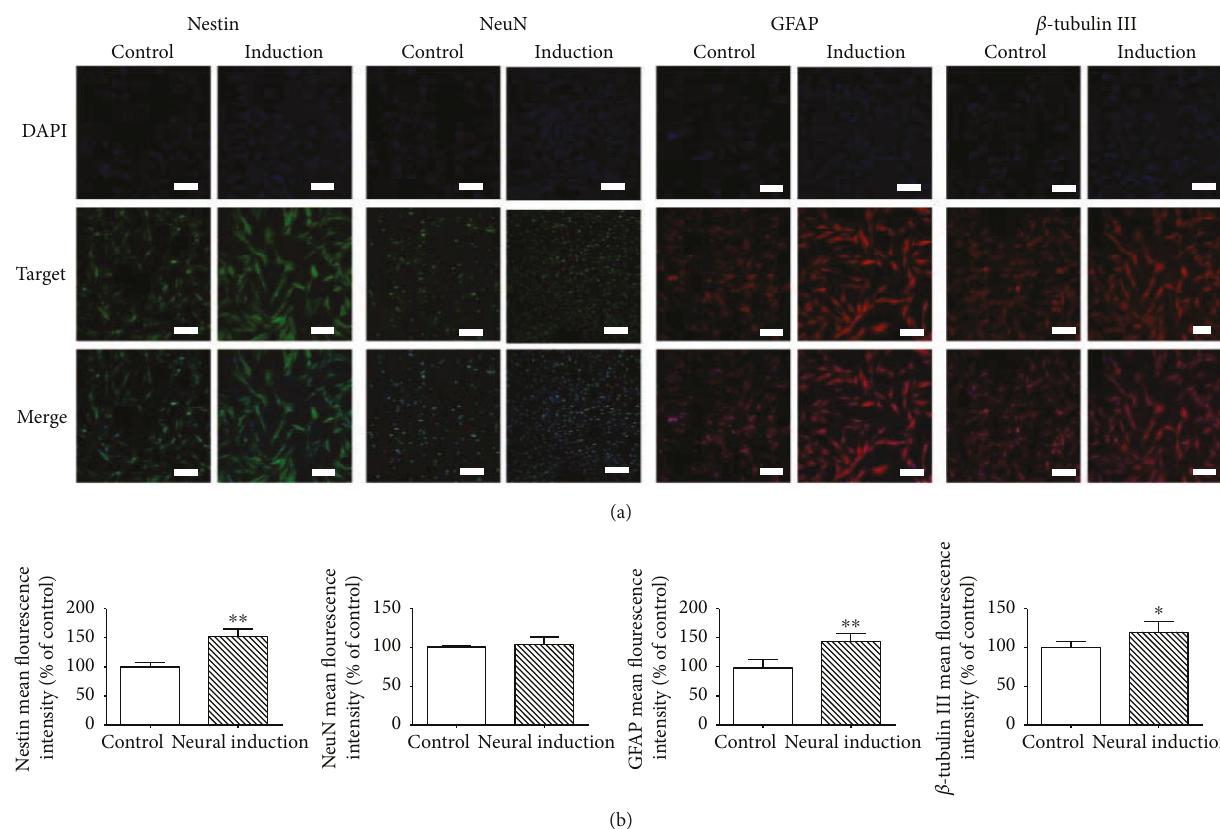
Figure 1: The neurogenic di ff erentiation potential of DPSCs. (a) The expressions of Nestin, NeuN, GFAP, and β -tubulin III. Scale bar: 200 μ m. (b) Quanti fi cation of the fl uorescence intensity of Nestin, NeuN, GFAP, and β -tubulin III. ∗ P < 0 05 , ∗∗ P < 0 01 versus the control